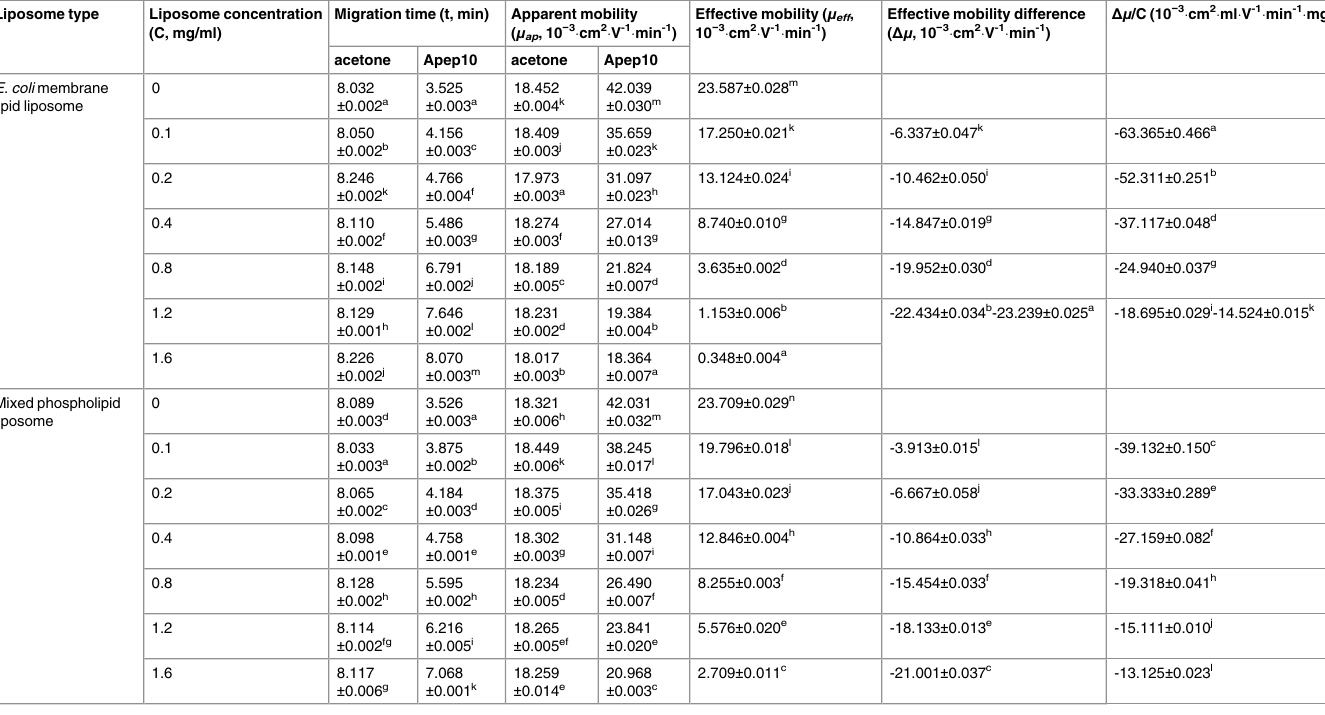
Results are expressed as mean value ± standard deviation (n = 3). Different letters (a, b, c, d ... ) in the same row represent a significant difference ( P <